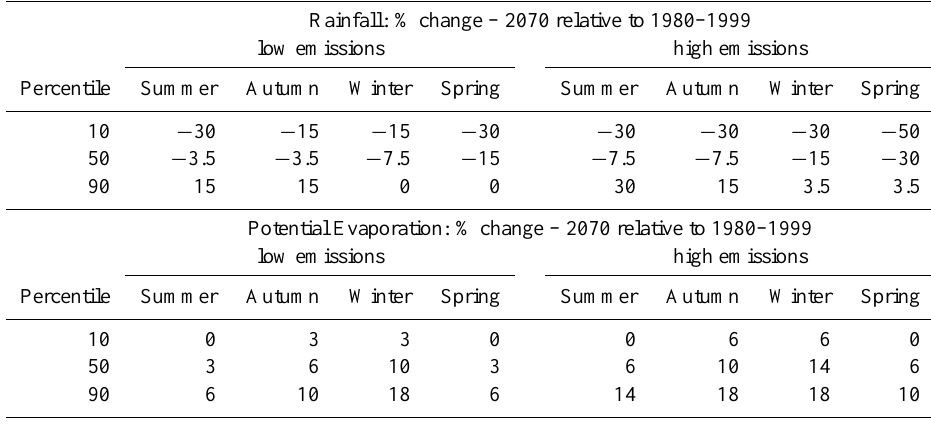
Table 3. Changes to rainfall and Potential Evaporation for the Fleurieu Peninsula region (from CSIRO, 2007).